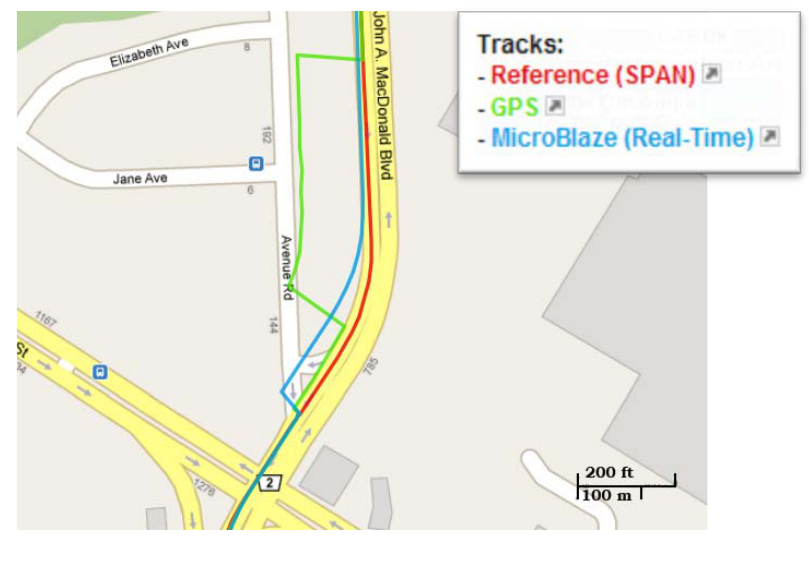
Figure 26. Land Vehicle Trajectory (2): Zooming-in outage